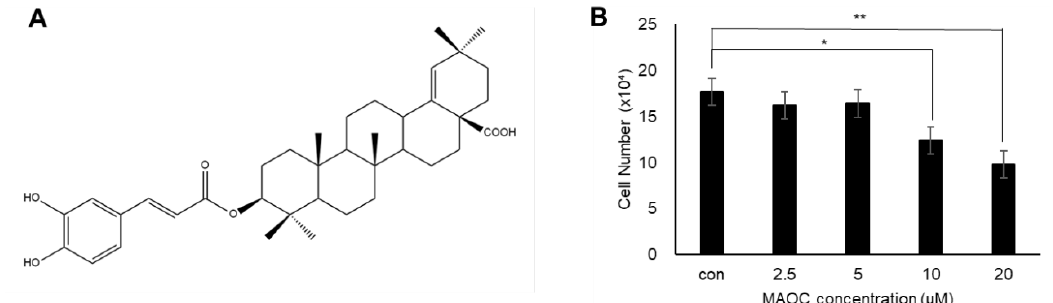
Figure 1. Cytotoxic effects of morolic acid 3- O -caffeate (MAOC) on 3T3-L1 preadipocytes. ( A ) Chemical structure of MAOC. ( B ) The number of 3T3-L1 cells treated with MAOC (0, 2.5, 5, 10, and 20 μM) for 24 h were measured. Data present the means ± SD for n = 3. * p < 0.05 and ** p < 0.01.